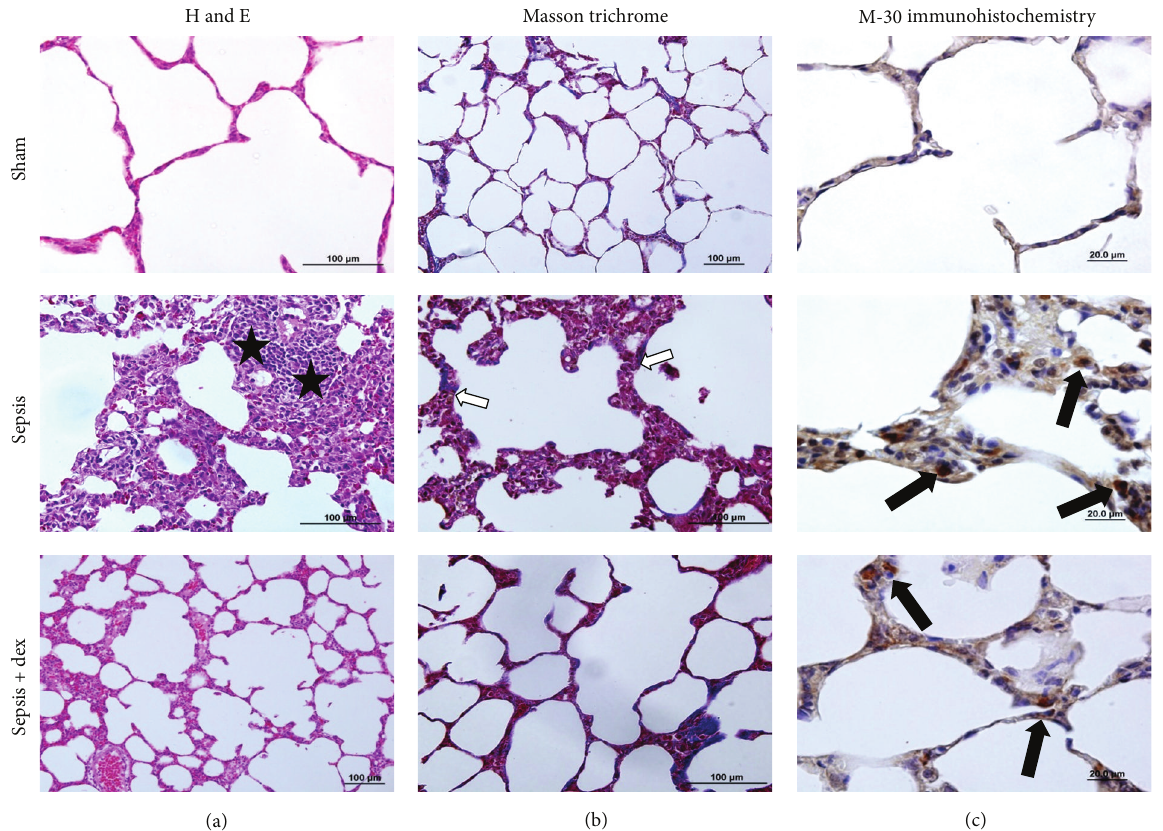
Figure 11: Representative histochemical and immunohistochemical staining in lung tissue (H and E, Masson’s trichrome, and M30) micro- graphs of experimental groups. (a) represented H&E, (b) represented Masson’s trichrome, and (c) represented M30 immunohistochemistry stained sections. ( 󳀅 ) showed mononuclear cell infiltration (white arrows) resembled collagen content of the parenchyma; (black arrows) represented M30 positive